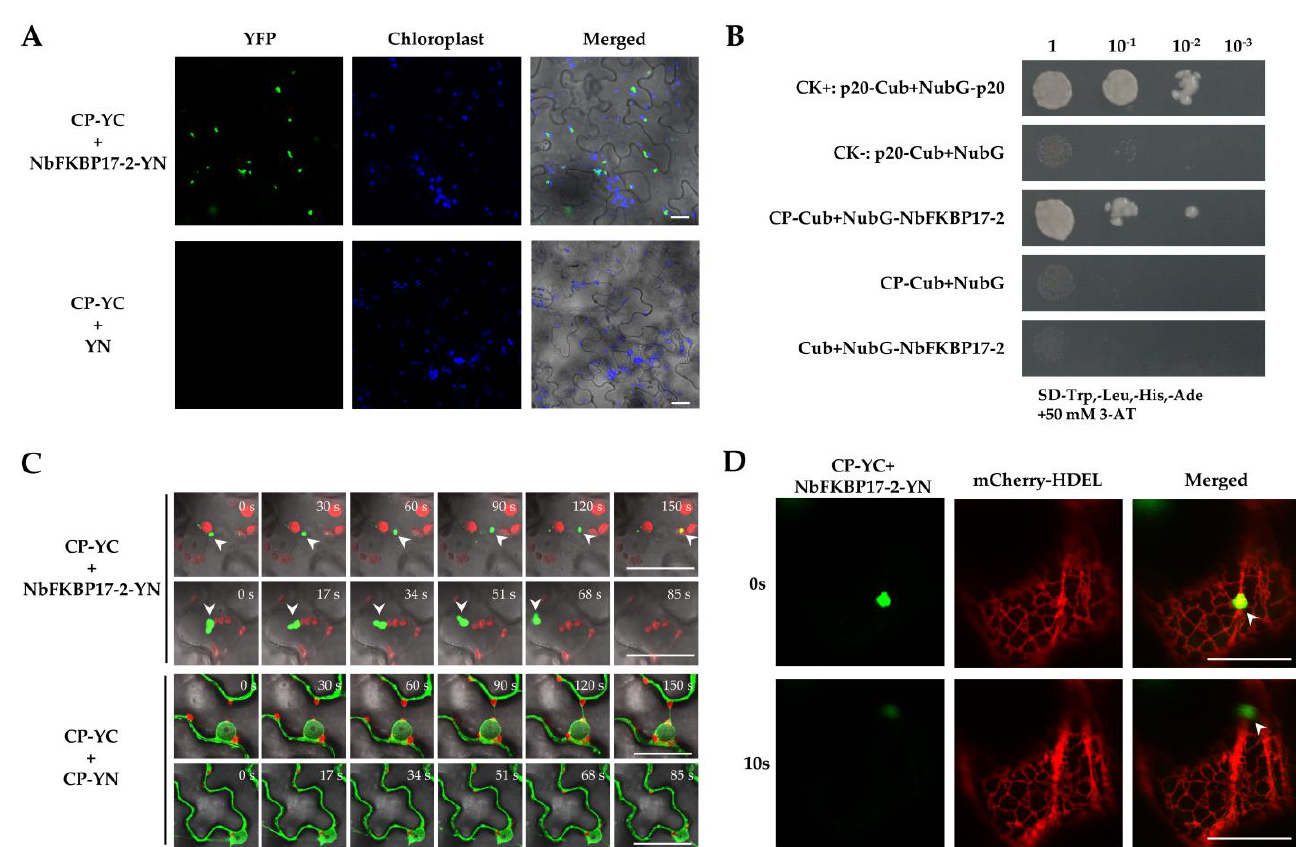
Figure 4. NbFKBP17-2 interacted and co-moved with citrus tristeza virus (CTV) CP in Nicotiana benthamiana cells. ( A ) Bimolecular-fluorescence complementation assays. The CP fused to YFP C-terminal (CP-YC) was co-expressed with NbFKBP17-2 fused to YFP N-terminal (NbFKBP17-2-YN) by agroinfiltration on N. benthamiana leaves. Blue fluorescence represented chlorophyll autofluorescence. ( B ) Split-ubiquitin yeast two-hybrid assays. CP was fused to the C-terminal half of ubiquitin (Cub), NbFKBP17-2 was fused to the N-terminal half of ubiquitin (NubG). Yeast cell of co-transformed with p20-Cub and NubG-p20 was used as a positive control and p20-Cub and NubG was used as a negative control, respectively. A series of dilutions (1, 10 − 1 , 10 − 2 and 10 − 3 ) were shown at the top of the figure. ( C ) Time-lapse images of CP/NbFKBP17-2 interaction and CP self-interaction. Two panels of each interaction combination were the captured signals in two fields. Red bodies were chloroplasts with chlorophyll autofluorescence signals. ( D ) Co-localization of CP/NbFKBP17-2 interaction complexes with endoplasmic reticulum marker mCherry-HDEL. The arrow heads pointed to CP/NbFKBP17-2 interaction complexes. Confocal images were taken at 48 hpi. Bars, 20 μm.